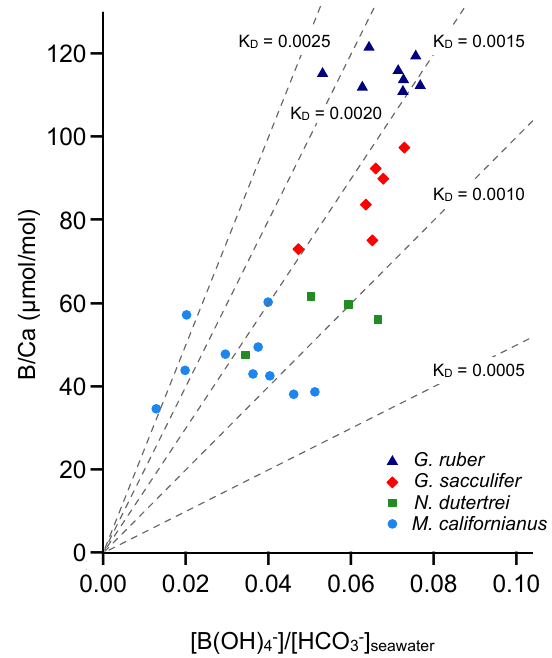
Fig. 9. M. californianus B/Ca from the inner prismatic layer 2000– 2009 in blue circles plotted with planktonic foraminiferal B/Ca from Foster (2008): N. dutertrei in green squares, G. sacculifer in red diamonds, and G. ruber in navy